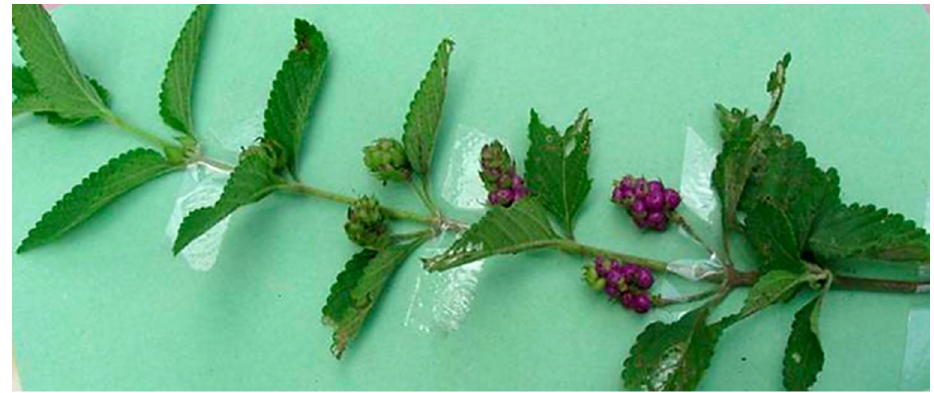
Figure 1. Photo of Lantana ukambensis (Verbenaceae) (Vatke) Verdc (Photograph by Sawadogo W.R., 2011).